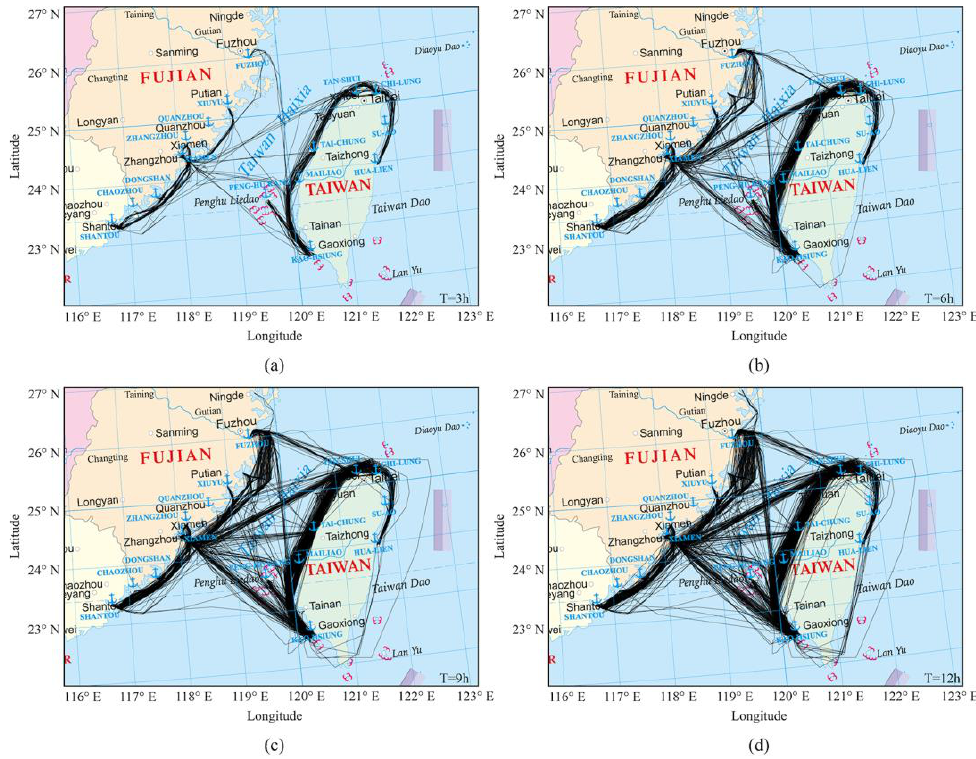
Figure 4. Ship trajectories obtained with different time difference thresholds between consecutive trajectory points. ( a – d ) correspond to the time difference thresholds of 3 h, 6 h, 9 h, and 12 h, respec- tively.